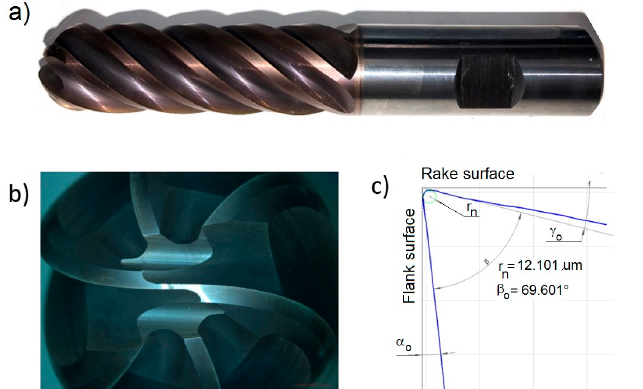
Figure 6. Ball end milling cutter SECO JS730200D3B.3Z6 ‐ HXT. ( a ) an overview, ( b ) a frontal view, ( c ) cutting edge geometry in the orthogonal plane.